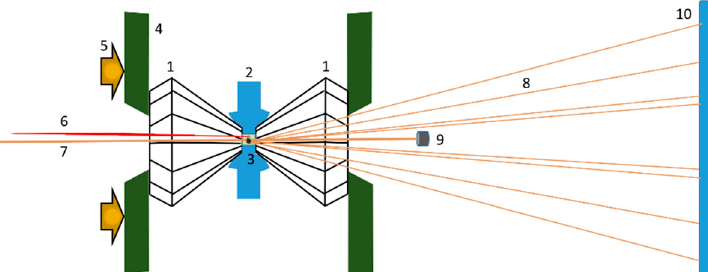
Figure 1. Scheme of the experimental set-up at the XPRESS beamline. (1) Pair of identical diamonds; (2) metal foil with a hole at the center (sample chamber); (3) sample chamber (sample, ruby, pressure transmitting medium (PTM)); (4) backing plates holding diamonds; (5) force pushing diamonds; (6) laser for ruby fluorescence excitation; (7) incident monochromatic x-ray microbeam; (8) diffracted x-rays; (9) beam stop blocking the direct beam; (10) image plate detector recording the position and intensity of the diffracted x-rays.